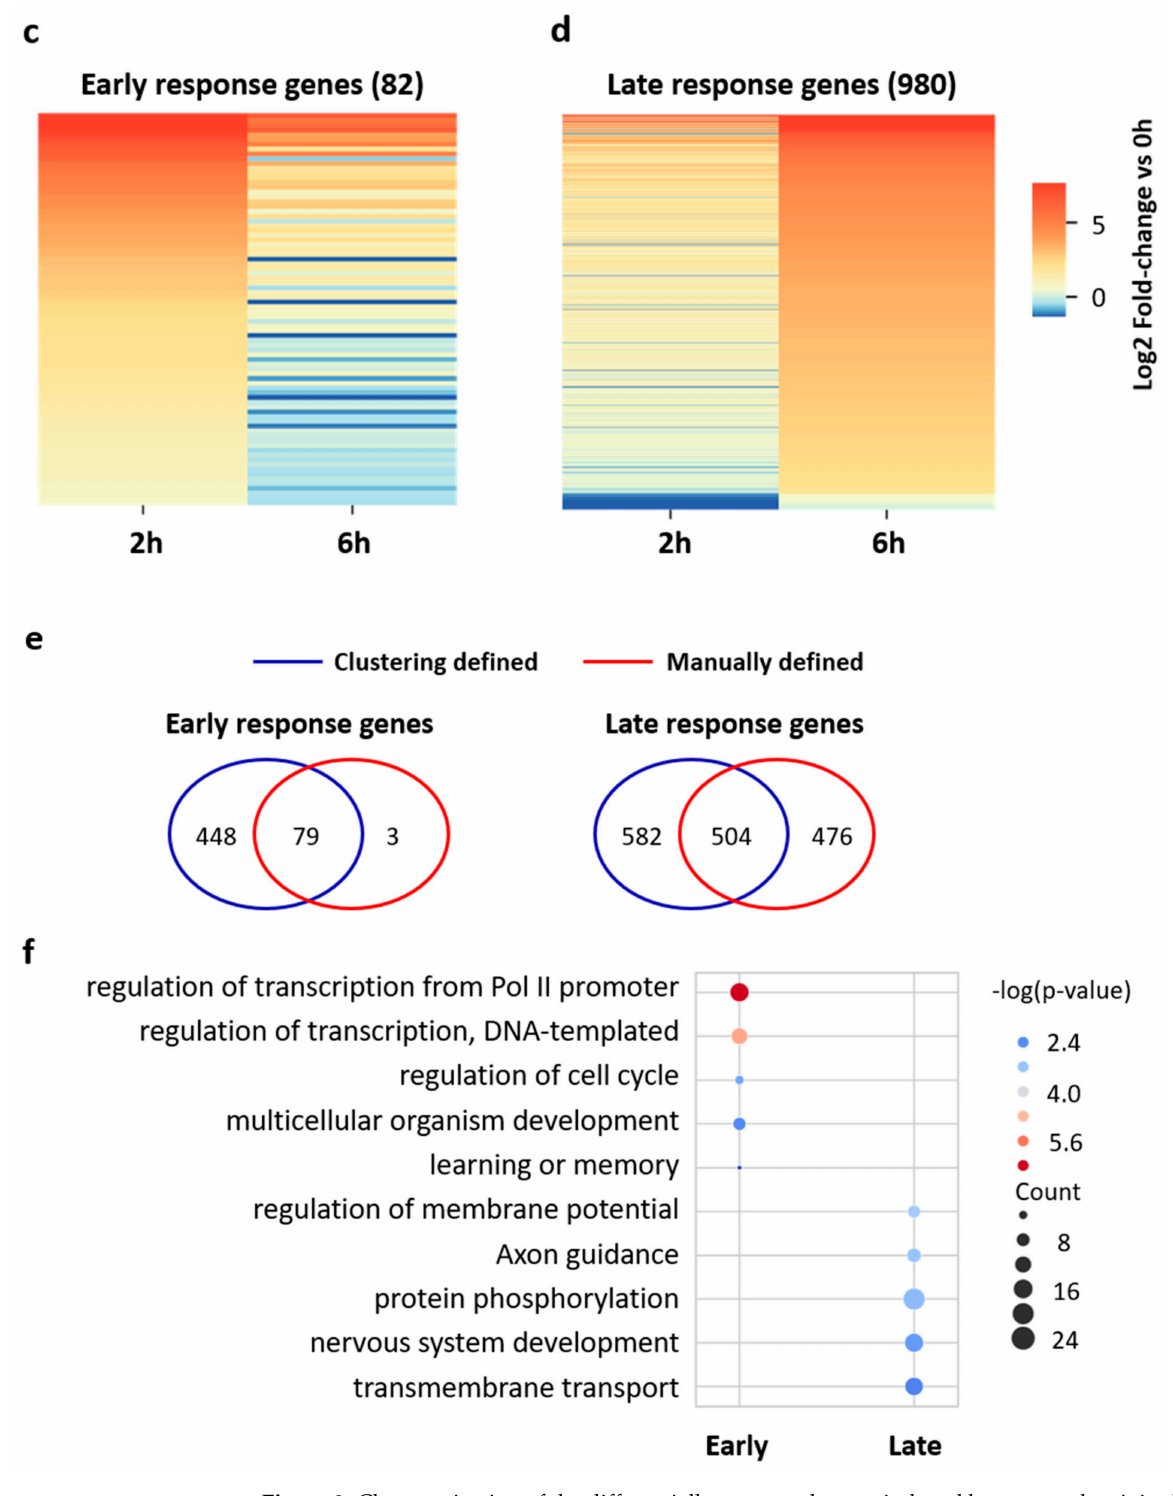
Figure 3. Characterization of the differentially expressed genes induced by neuronal activitydepolar- ization. ( a ) Clustering of the DEGs using Z-score normalization. The DEGs were grouped into four clusters. ( b ) Line plot showing the average expression level for each cluster. ( c , d ) Heatmap showing the gene expression profiles of manually defined early response genes ( c ) and late response genes ( d ). ( e ) Venn diagram showing the overlap between the clustering defined and manually defined early response genes (left) and late response genes (right). ( f ) GO annotation of the early response genes and late response